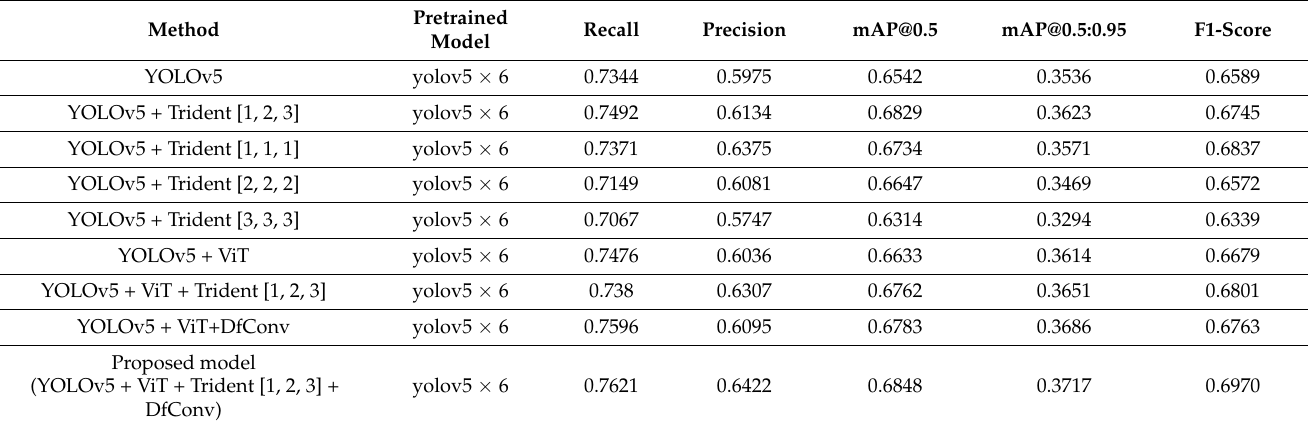
Table 2. Performance comparison of the ablation experiment of each